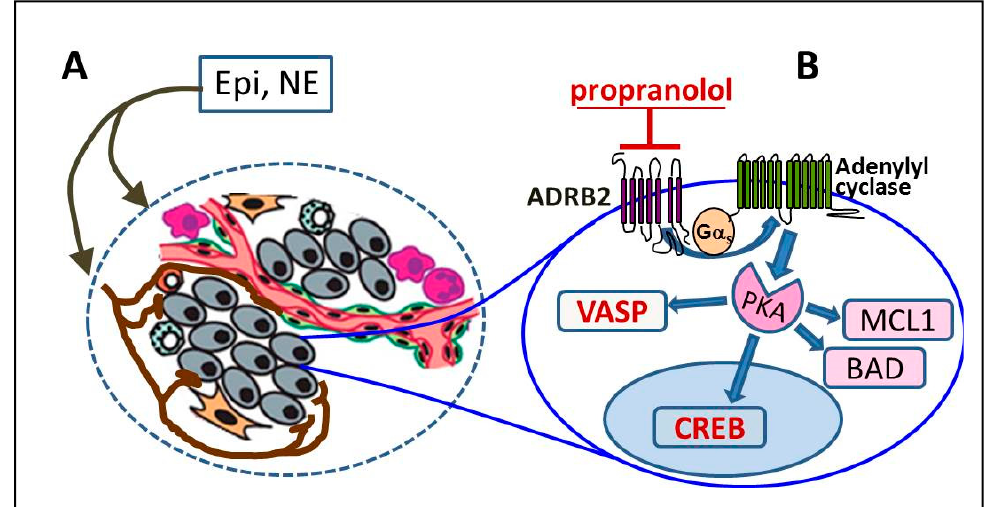
Figure 1. ADRB2 signaling in prostate cancer. ( A ) epinephrine (Epi) and norepinephrine (NE) from circulation and secreted locally by sympathetic nerves, neurodifferentiated prostate cancer cells and macrophages activate anti-apoptotic signaling in prostate cancer cells and stimulate angiogenesis and invasion; ( B ) Activation of ADRB2 signaling (that can be inhibited by propranolol) induces phosphorylation of PKA substrates pS133CREB, pS157VASP, p75BAD and increases expression of myeloid cell leukemia 1 (MCL-1). Dephosphorylations of vasodilator-stimulated phosphoprotein (VASP) and cAMP response element binding protein (CREB) reflect inactivation of β -2 adrenergic receptor/cAMP-dependent protein kinase (ADRB2/PKA) signaling pathway by propranolol, whereas decreased levels of MCL-1 and p75BAD predict whether propranolol will sensitize prostate cells to apoptosis.